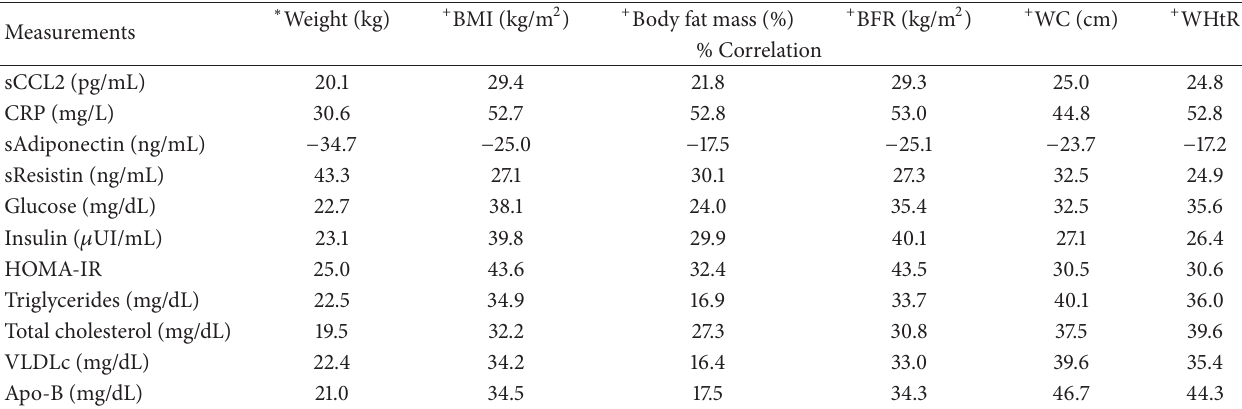
Table 2: Correlations soluble levels of adipokines and metabolic markers with body adiposity.